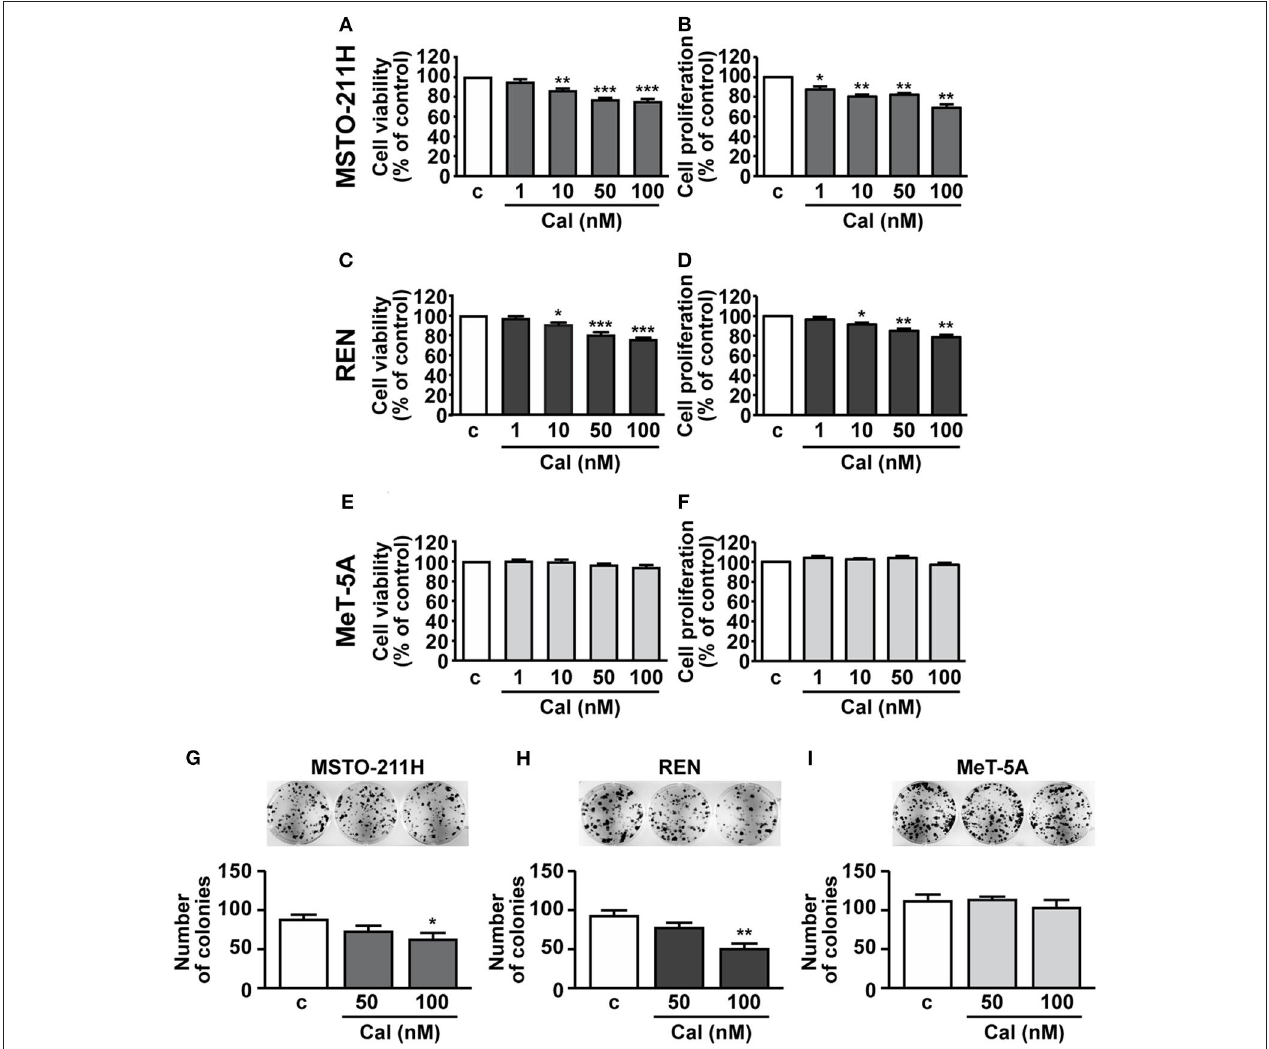
FIGURE 2 | Effect of calcitriol on viability and proliferation of MPM cells and pleural mesothelial cells. MSTO-211H and REN MPM cells, and MeT-5A mesothelial cells, were serum deprived for 12h, then cultured for 24h in the absence (c, control) or presence of calcitriol (Cal), at the concentrations indicated. Cell viability (A,C,E) and proliferation (B,D,F) were assessed by MTT and BrdU, respectively. Maximum inhibition at 100nM Cal in MSTO-211H (A,B) : 24.7 and 31.1%; REN: 24 and 21.3%, for viability and proliferation, respectively. Results, expressed as percent of control are means ± SEM. * P < 0.05, ** P < 0.01, *** P < 0.001 vs. c; n = 8 for MTT, n = 4 for BrdU. Representative colony formation in MSTO-211H (G) , REN (H) , and MeT-5A cells (I) untreated (c, control) or treated for 10 d with calcitriol (Cal), at the concentrations indicated. Results are means ± SEM. * P < 0.05 and ** P < 0.01 vs. c; n = 3.